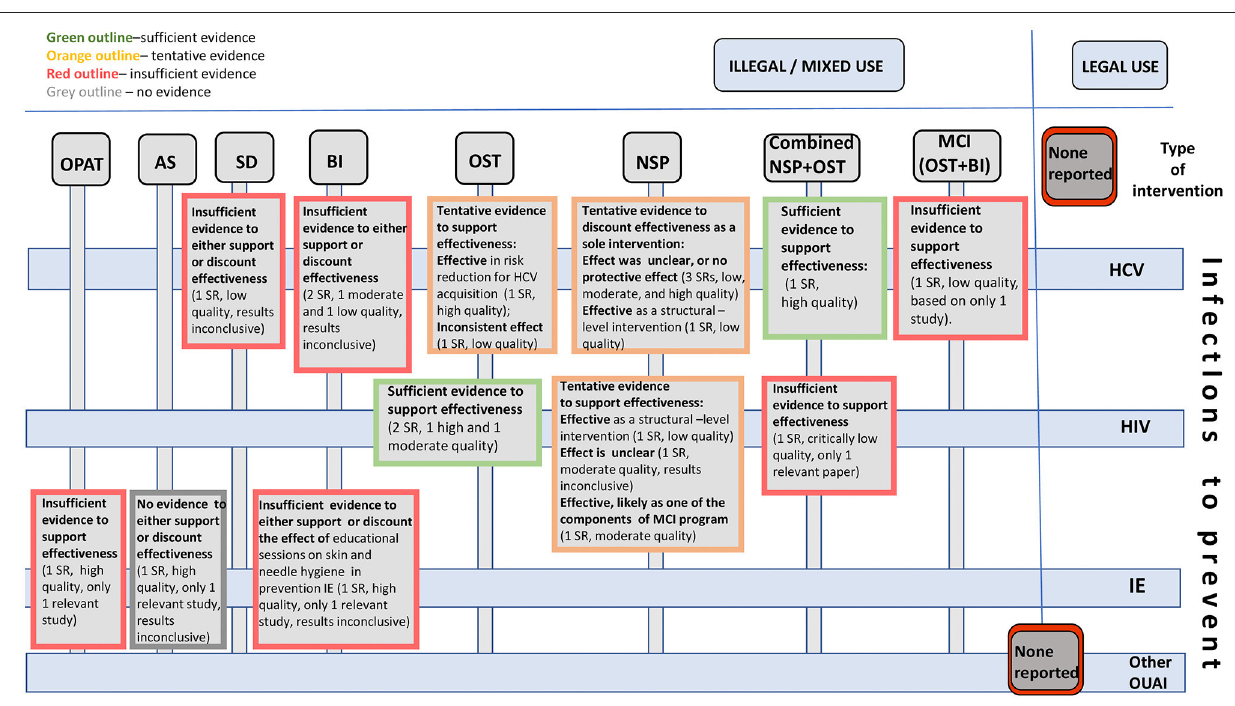
FIGURE 3 | Effectiveness of interventions to prevent infections in opioid users: existing evidence and knowledge